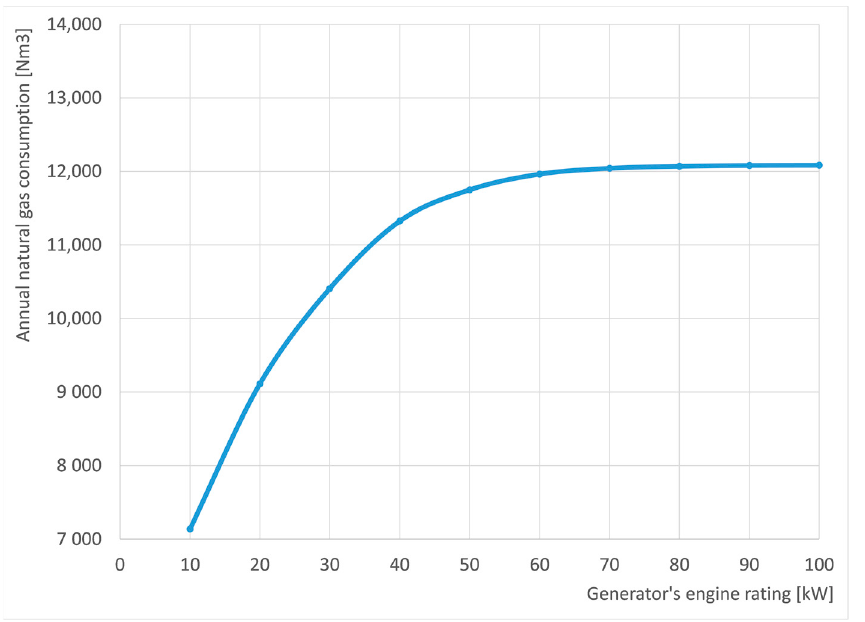
Figure 9. E ff ect of the generator’s rated power on the annual natural gas consumption ( Soc min = 0.36 ).